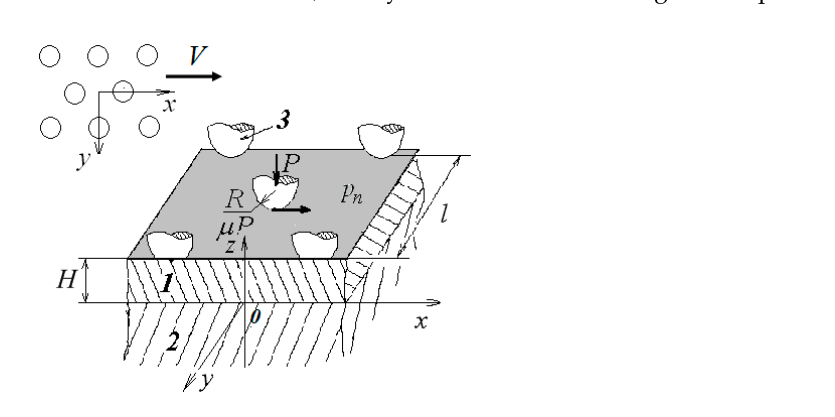
Figure 1. Scheme of multiple contact of viscoelastic coating (1) bonded to a rigid substrate (2) and a periodic system of indenters (3).